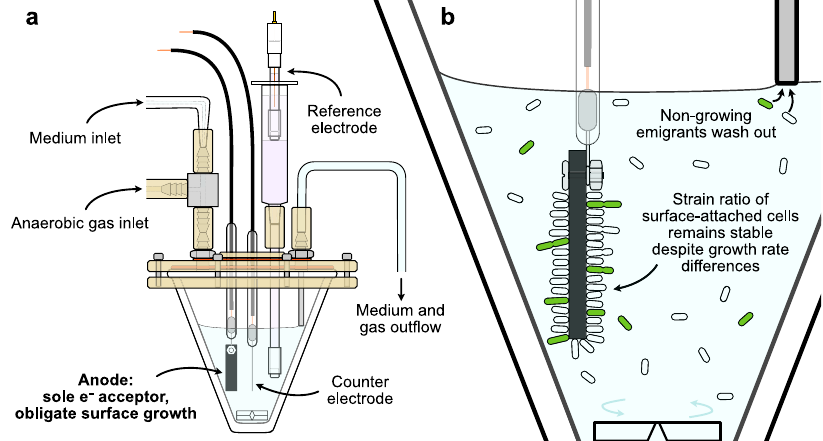
Fig. 1 Experimental platform. a Anaerobic three-electrode bioreactor. Fresh sterile anaerobic medium is pumped at a constant rate into a growth chamber under positive pressure from a fl ow of sterile humidi fi ed argon. Both spent medium and argon exit through an air-locked outlet. Cells are grown on a graphite working electrode poised at anodic potentials with a platinum counter electrode and a Ag/AgCl reference electrode to control the voltage. A magnetic stir bar mixes the planktonic phase. b Only cells attached to the anode can grow. Hence, the strain ratio in the planktonic phase equals the ratio on the anode times the relative growth rate (see Note in Supplementary